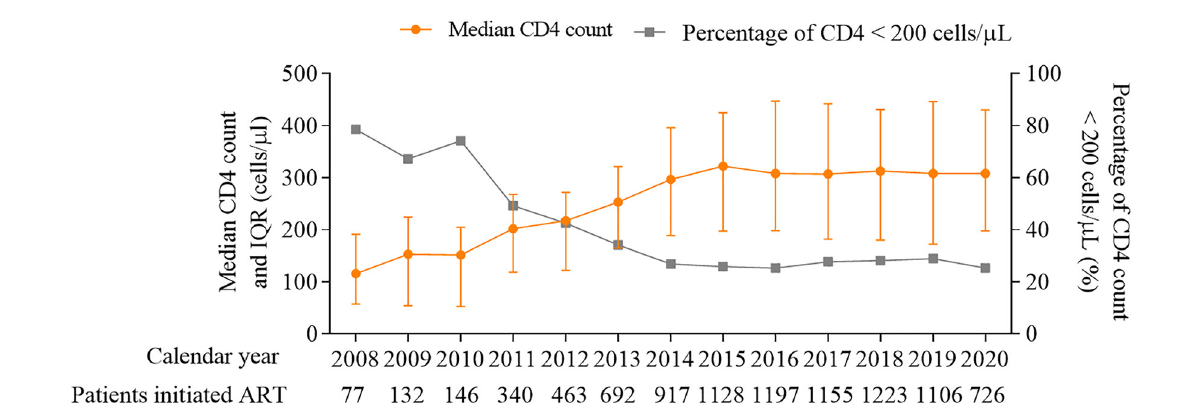
FIGURE2 Median CD4 count (cells/ µ L) and percentage of patients with CD4 count < 200 cells/ µ L at ART initiation, 2008–2020. ART, antiretroviral